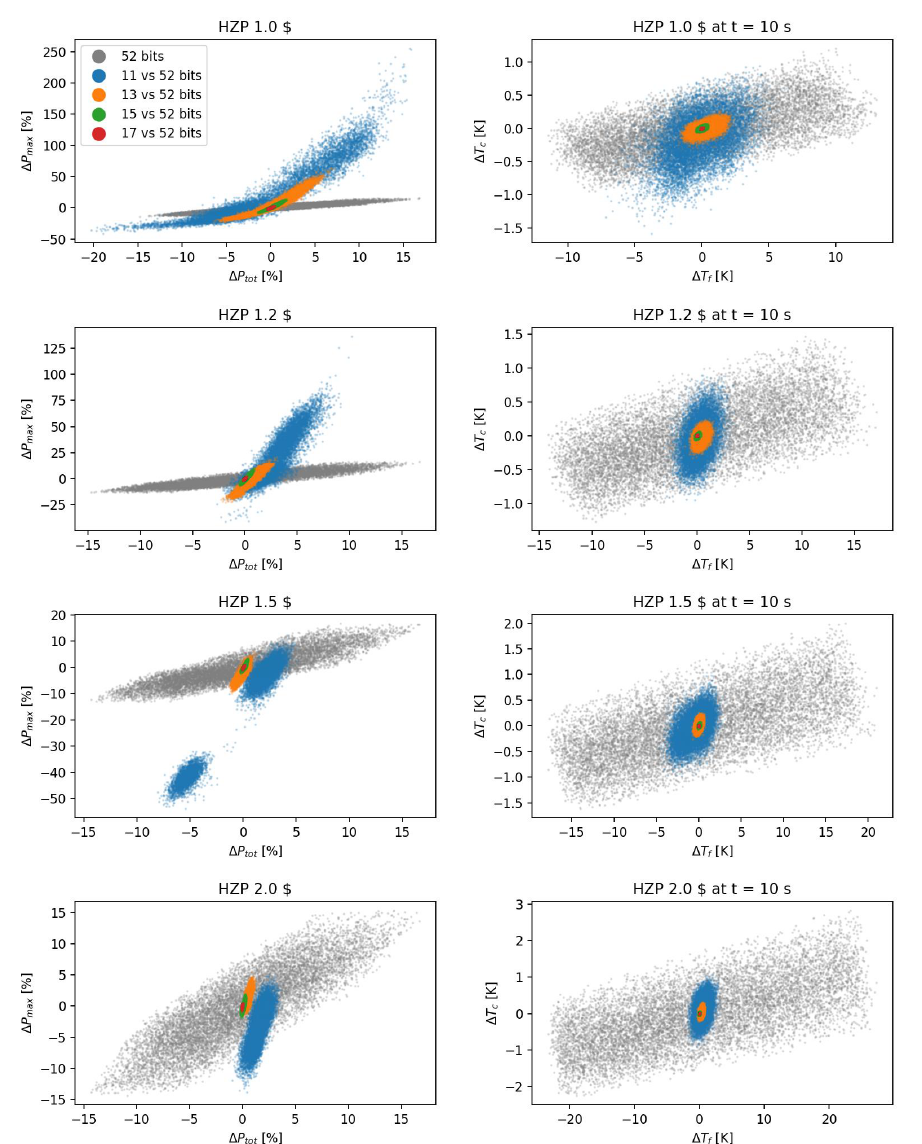
Figure 4. Reduced-to-full precision discrepancy of power, fuel temperature and coolant